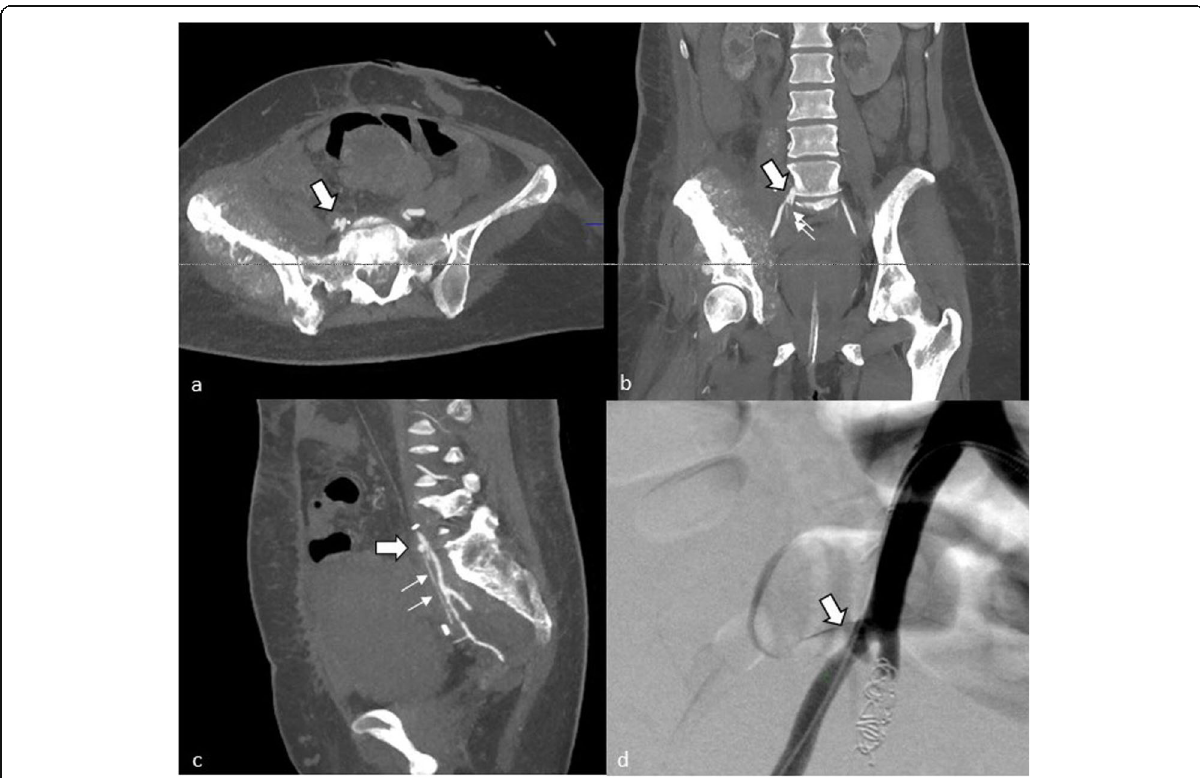
Fig. 1 Case #1: Contrast enhanced computed tomography confirmed the ureteroarterial fistula (large arrows) and demonstrated even extravasation into the right ureter (small arrows) ( a , b , c ). Angiography shows a defect at the iliac junction (large arrow). Coil embolization of the internal iliac artery has already been performed ( d